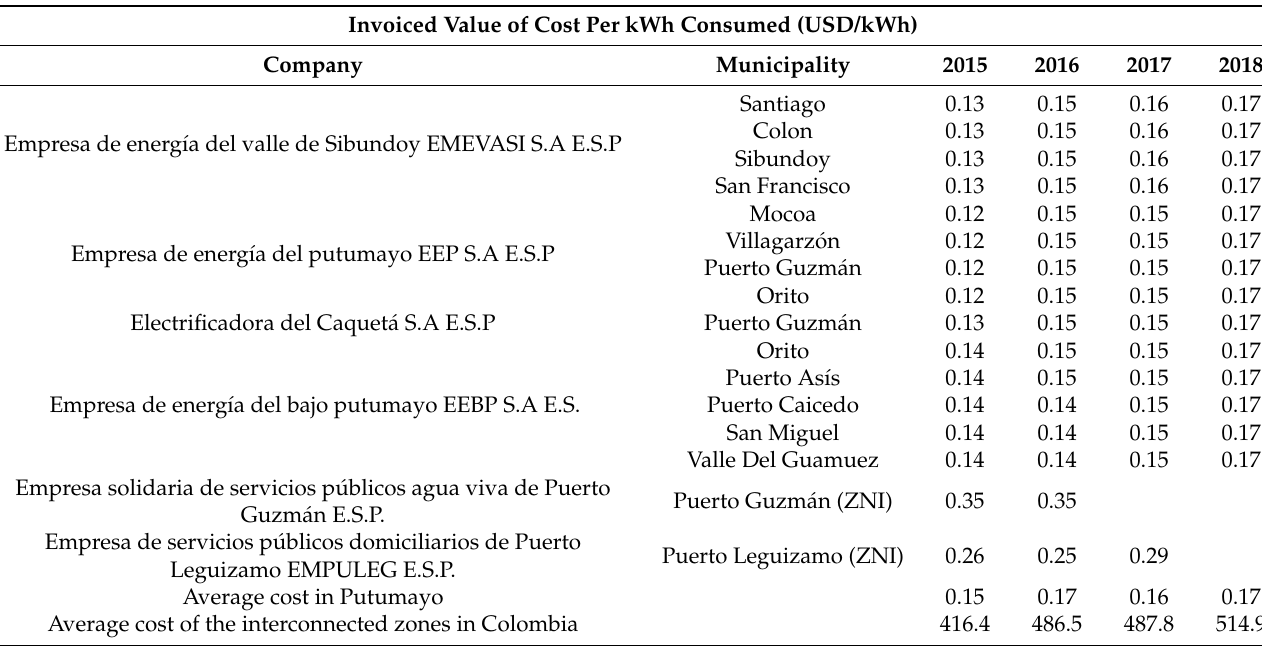
Table 11. Energy costs in Putumayo by company and